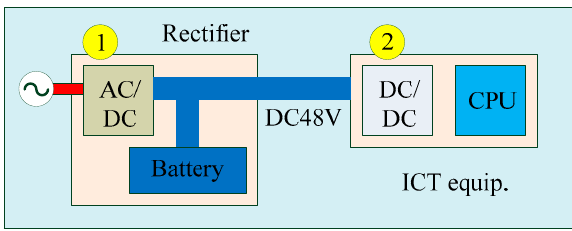
Figure 1. The basic two-stage structure of ICT equipment.